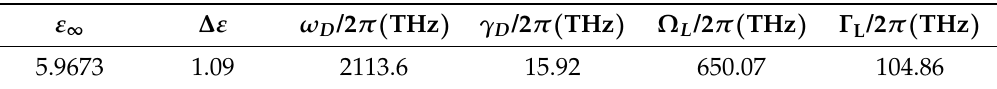
Table 2. The specific parameters of the Drude-Lorentz model for the gold